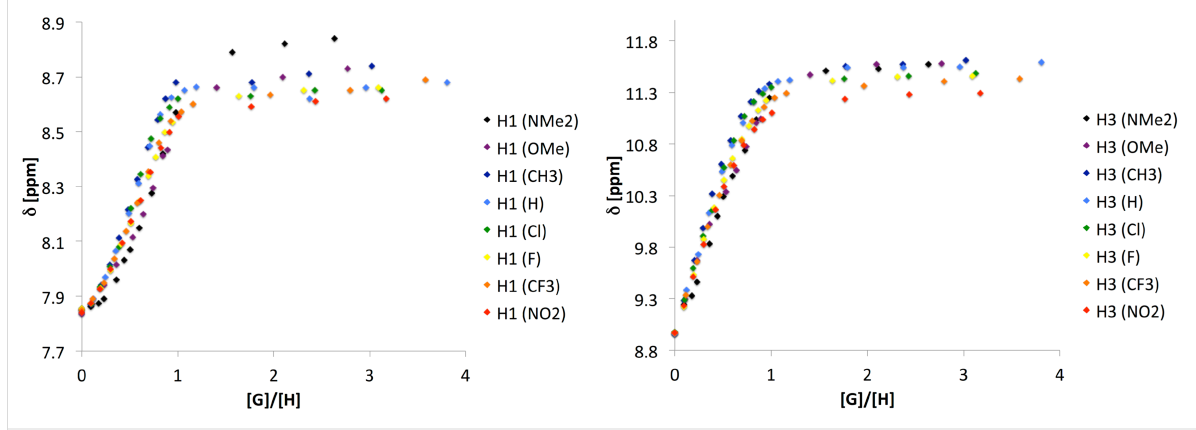
Figure 6: Collective titration curves (H1/H7 and H3/H5 chemical shifts, CDCl 3 ) for complex of 1 with substituted benzoates.